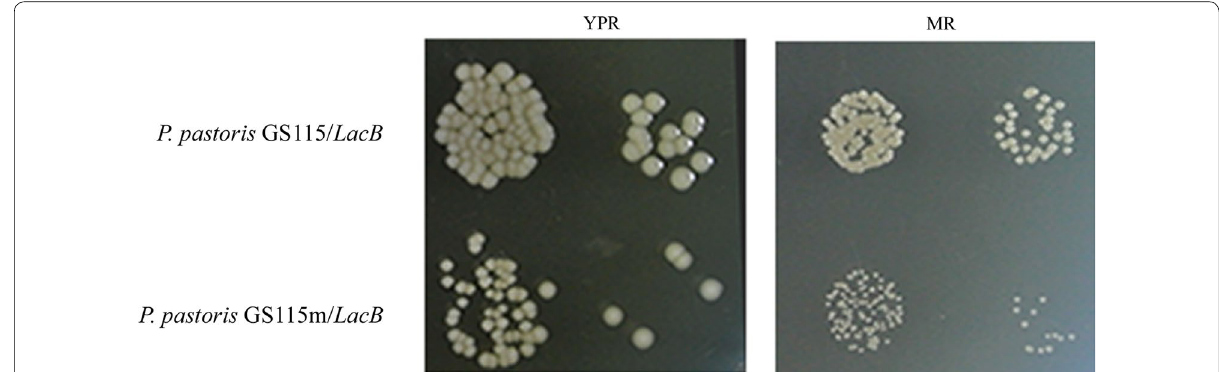
Fig. 5 The phenotypes of P. pastoris GS115/ LacB and P. pastoris GS115m/ LacB grown on YPR and MR. The two strains were grown in liquid YPR medium to an OD 600 of ~ 6, and the cultures were diluted to an OD 600 of ~ 1, and then serially diluted. After dilution with 10 3 and 10 4 times, 5 μL and 10 μL of the diluted cultures were spotted onto YPR and MR, respectively. The colonies were recorded after incubation at 28 °C for 72